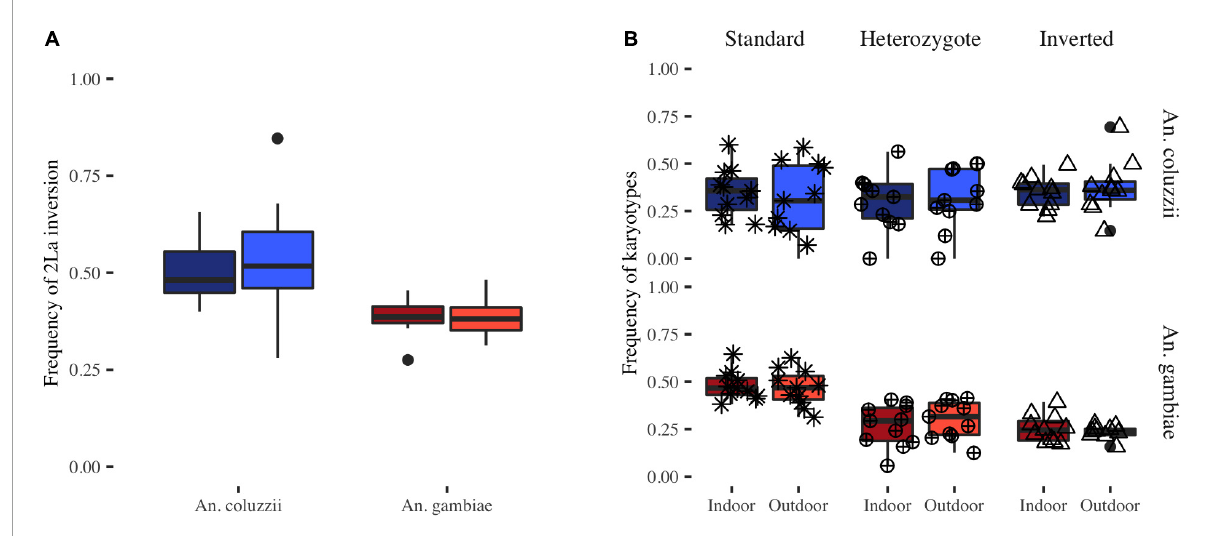
FIGURE2 Spatial distribution of the 2La inversion in function of the collection location. (A) Boxplots show the 2La inversion frequency in mosquitoes collected indoor (darker colors) and outdoor (lighter colors) throughout the year ( A. gambiae in red, A. coluzzii in blue). (B) Frequency of each 2La inversion karyotype (asterisk, standard; circle with cross, heterozygote; triangle, inverted) for A. gambiae and A. coluzzii specimens captured indoor and outdoor.